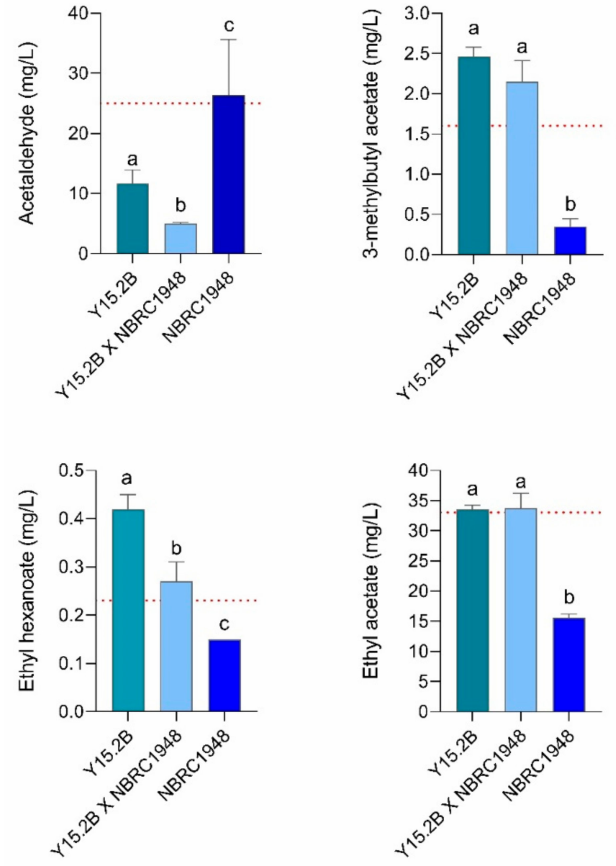
Figure 6. Concentrations of flavor-active compounds (mg/L) after 2 L wort fermentation (15 ◦ P, 12 ◦ C). Values are means of two independent replicates; bars represent error range. Different superscript letters indicate significant differences ( p < 0.05) as determined by one-way ANOVA and Tukey’s test. For each compound, the relative perception threshold is reported as dotted red line